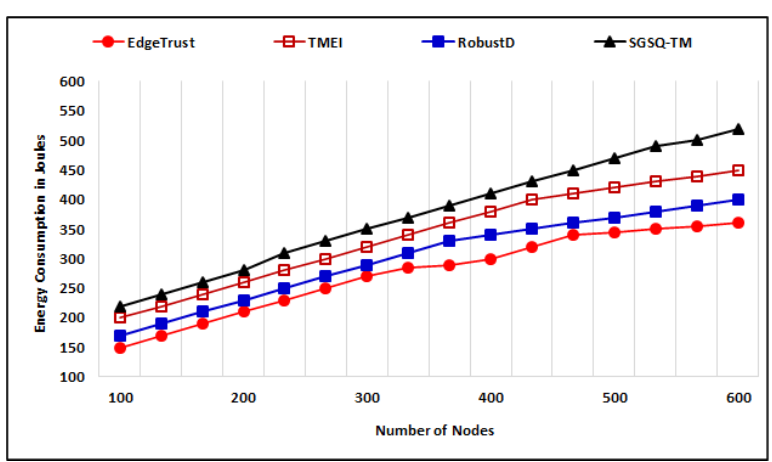
Figure 15. Average energy consumption